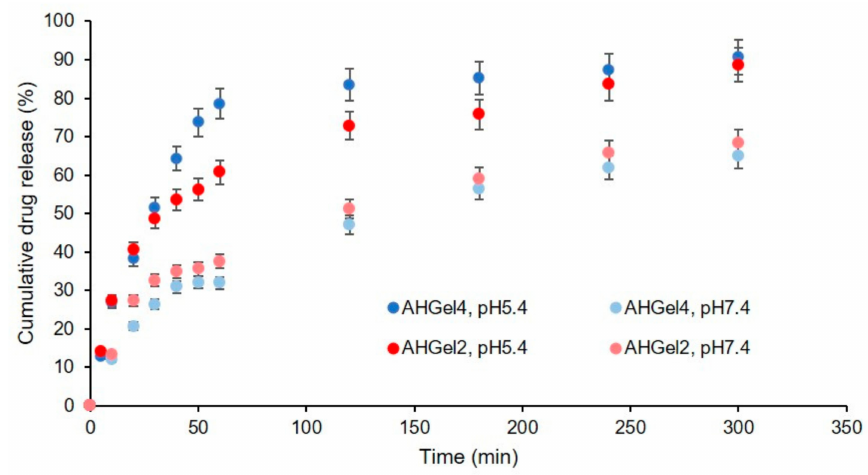
Figure 6. Cumulative drug release of Amox from gelatine-based hydrogel. Means ± SD, n = 3. The difference between Amox released from AGel2 and AHGel4 at each pH was low.